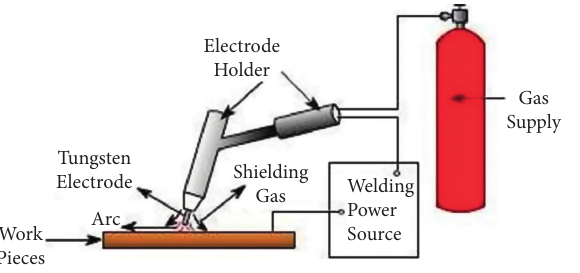
Figure 1: Welding system of